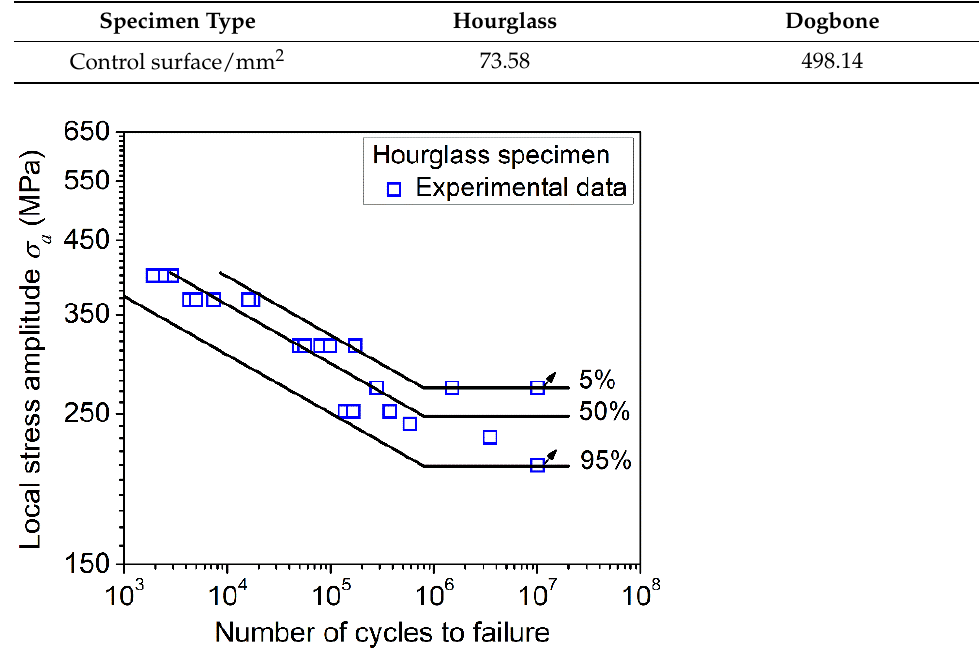
Figure 10. Comparison of predicted P-S-N curves with experimental data for hourglass specimens, in which the arrows denote the unbroken specimens at the associated cycles.